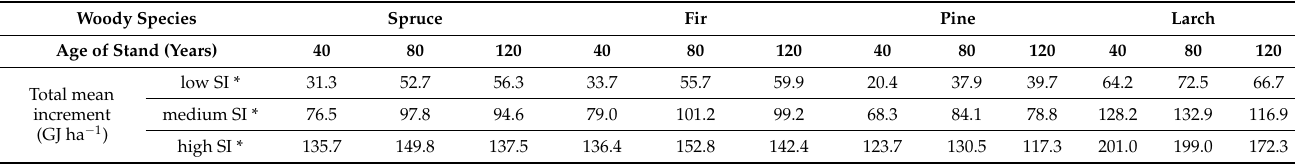
Table 3. The development of energy reserves in total mean annual increments of stands with low, medium, and high site